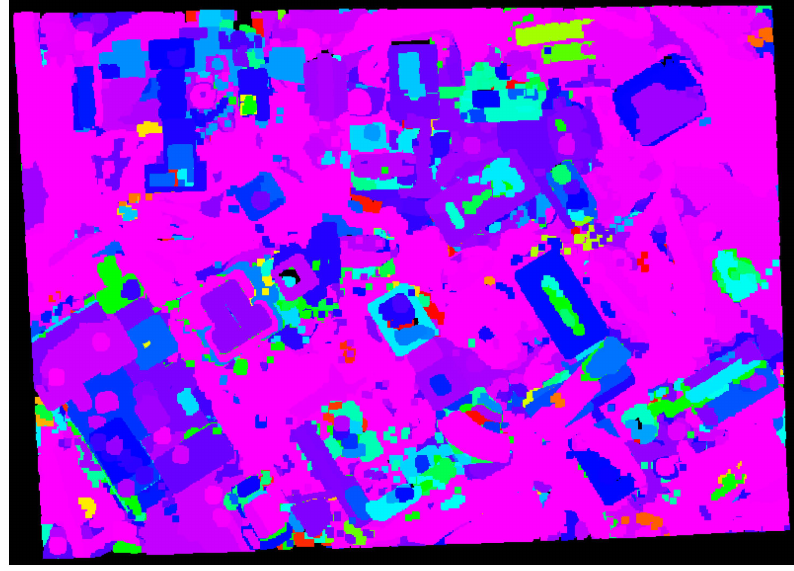
Figure 18. Segmentation results based on the region growing approach over University of Calgary.